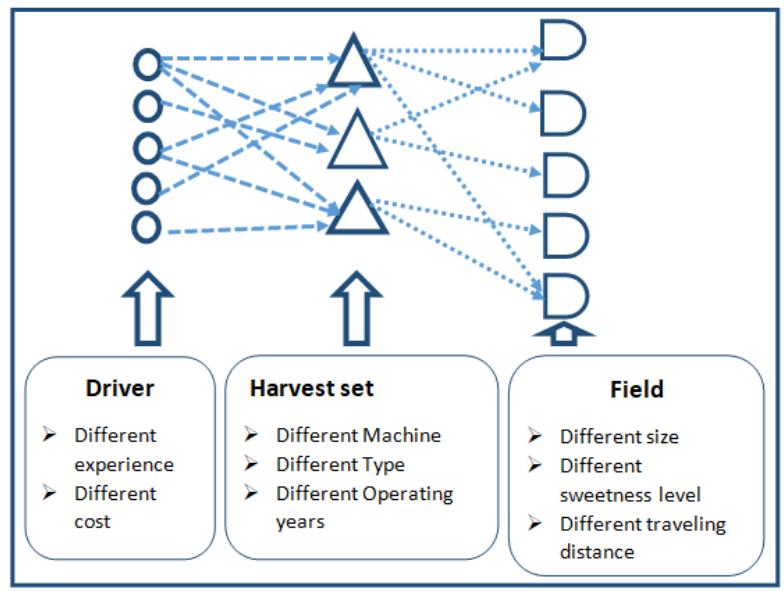
Figure 1. The unsolved special case of the generalized assignment problem (S-GAP).